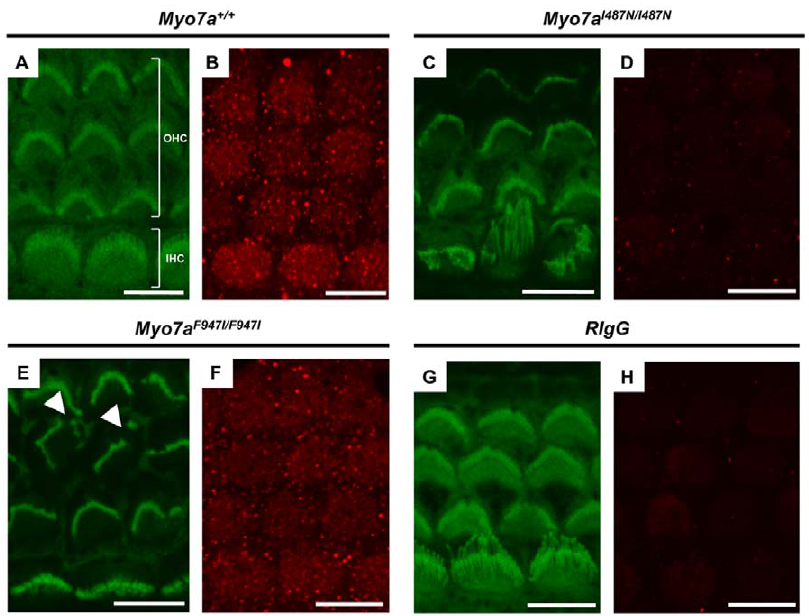
Figure 8. Immunohistochemistry of P5 sensory epithelia. Images of phalloidin (green) and Myo7a (red) stained cochlear sensory epithelium from P5 Myo7a + / + ( A and B ), Myo7a I487N/I487N ewaso ( C and D ) and Myo7a F947I/F947I dumbo ( E and F ) mice at the basal cochlear level. No Myo7a expression is evident in Myo7a I487N/I487N ewaso mutant tissue ( D ), and may be slightly reduced in Myo7a F947I/F947I dumbo mutants ( F ). No difference in protein localisation was observed between wilt-type and Myo7a F947I/F947I dumbo tissue. Phalloidin staining highlights abnormal IHC structure in Myo7a I487N/I487N ewaso mutants ( C ) and OHC hair bundles appear misorientated and/or fragmented in Myo7a F947I/F947I dumbo (arrowheads in E). Scale bar; 8 m M (A–H).